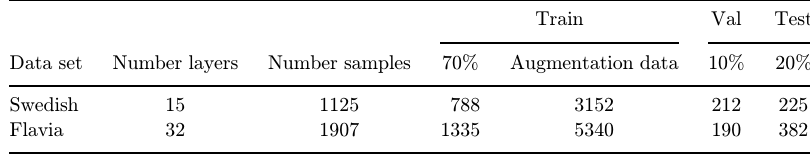
Fig. 6. Data with speci¯c augmented (with re°ection Table 2. Partition data.